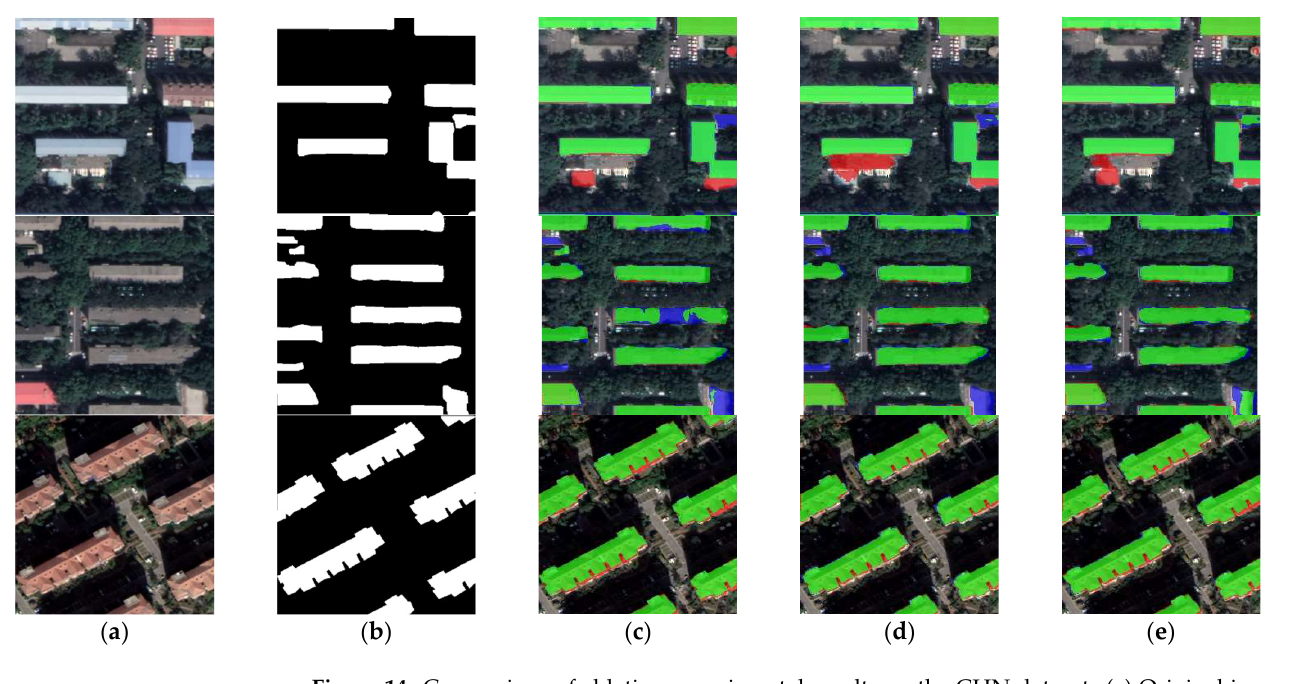
Figure 14. Comparison of ablation experimental results on the CHN dataset. ( a ) Original image. ( b ) Ground truth. ( c ) ResNet +AAP. ( d ) ResNet +DGC. ( e ) ResNet +AAP +DGC. Note, in Columns ( b – e ), black, white, green, blue, and red indicate true, false, true-positive, false-negative, and false-positive, respectively. Table 4. Accuracy statistics of the ablation experiment on the CHN dataset. The best scores are highlighted in bold.